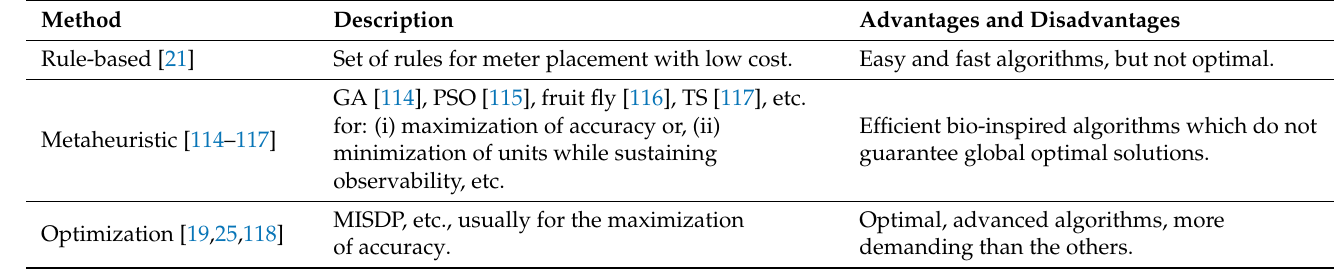
Table 5. Meter placement strategies